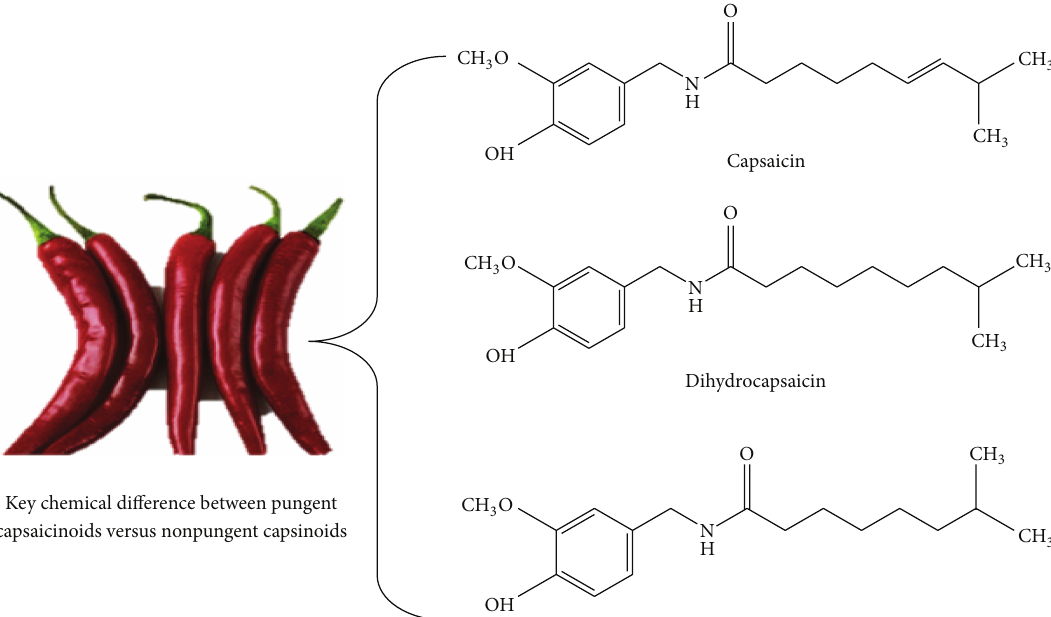
Figure 1: The structure of the